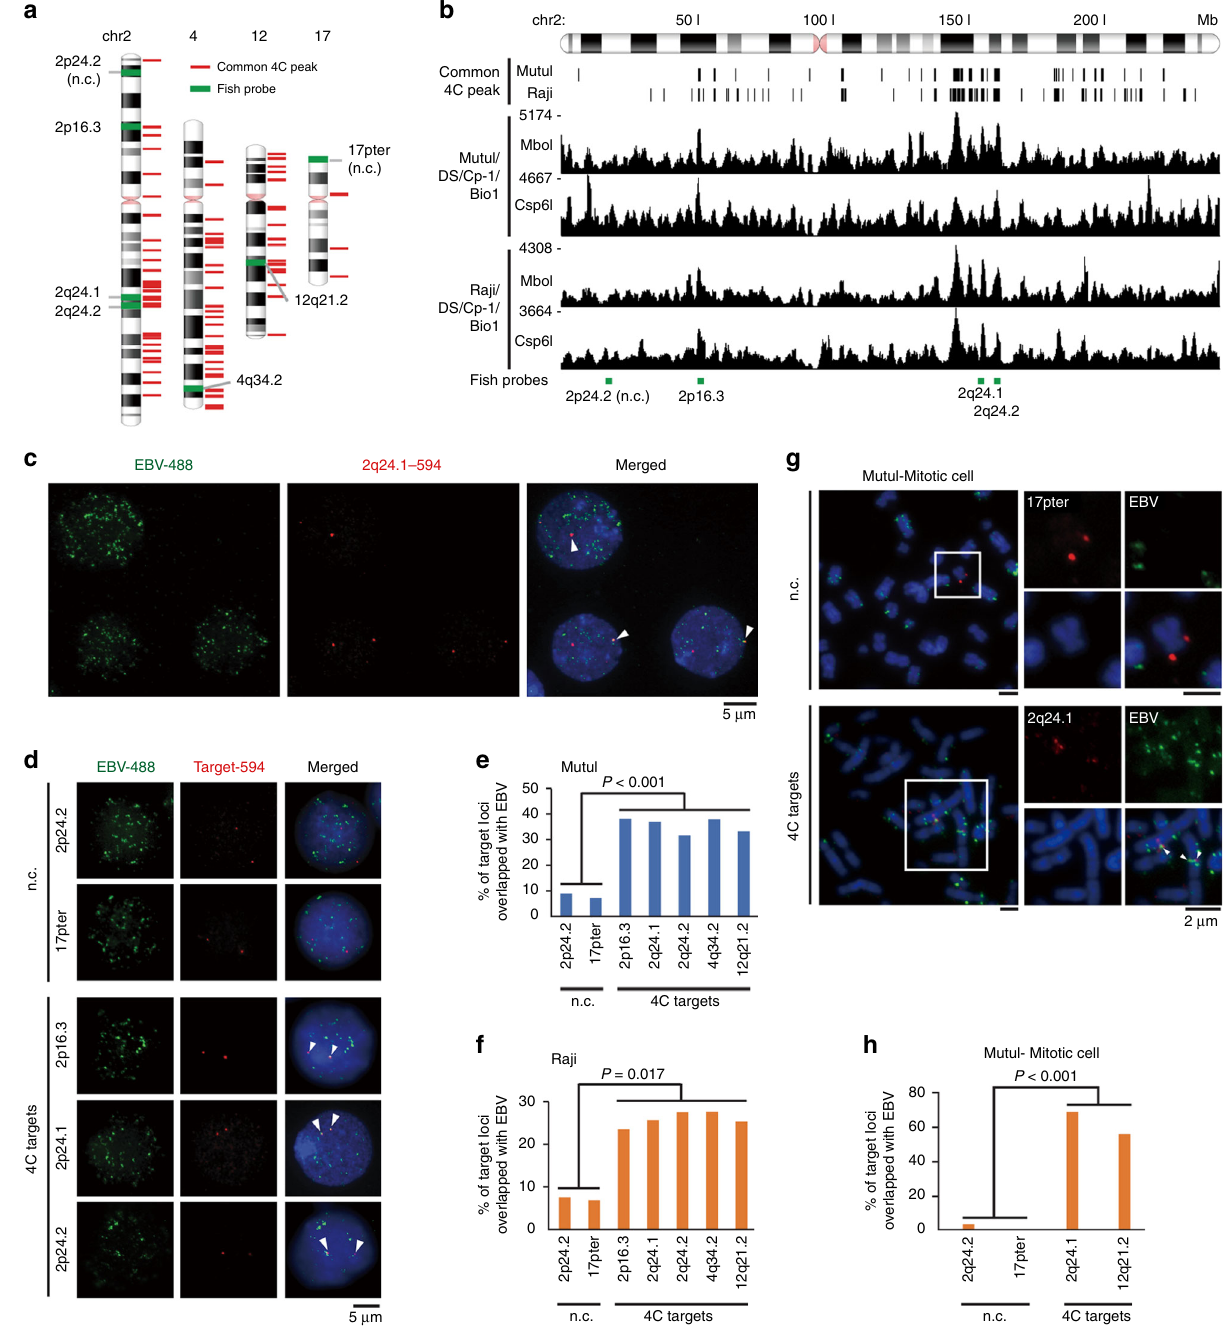
Fig. 2 Validation of 4C interaction sites by FISH. a Positions of FISH probes (green bars) on chr2, 4, 12, and 17. b Precise positions of FISH probes (green bars) on chr2 with common 4C peaks. c Representative images for interphase MutuI nuclei stained with dual FISH for EBV-488 (Oregon Green 488) and Target-594 (Alexa Fluor 594). d Representative images of interphase MutuI nucleus stained with dual FISH for EBV-488 and Target-594. e , f The percentage of co-localized FISH signals between EBV-488 and Target-594 in interphase nuclei from MutuI (panel e ) and Raji (panel f ) cells. The FISH signals were measured in more than 100 nuclei. g Representative images of mitotic MutuI nuclei stained with dual FISH for EBV-488 and Target-594. All arrows indicate co-localized FISH signals between EBV-488 and Target-594. h The percentage of co-localized FISH signals between EBV-488 and Target- 594 in mitotic chromosomes from MutuI cells. The FISH signals were measured in more than 50 nuclei. Error bar represents the standard deviation and P - value were calculated by two-sided Student t